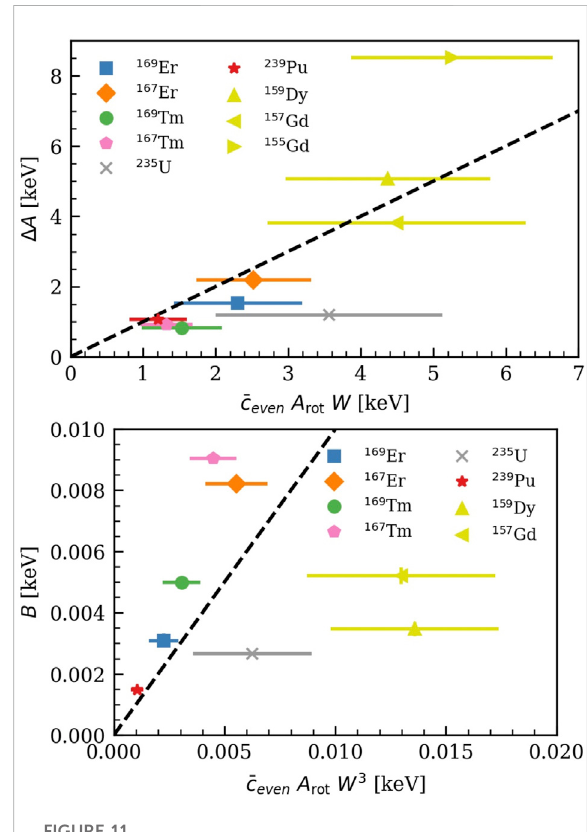
FIGURE 11 The size ofthe N 2 LOLEC, Δ A (toppanel) and theN 4 LOLEC, B (bottom panel), on the y -axis, compared to its expected size from the EFT power counting, on the x -axis. Error bands on the LEC distribution are small and can not been seen on the plot. The error bands on the x -axis encompass uncertainties between the 16th and 84th percentiles. Different nuclei are labeled in the legend of the plot. The black dashed line has slope =1 and is plotted to facilitate comparison of prior expectation with results from the posterior. The yellow colored symbols are results for rotational bands with bandheads K =3/2, all the others are K =1/2 bands. 99 Tc and 183 W are outliers and we exclude them from the both plots. We also exclude 155 Gd from the bottom plot only (LEC values for these nuclei can be found in Table